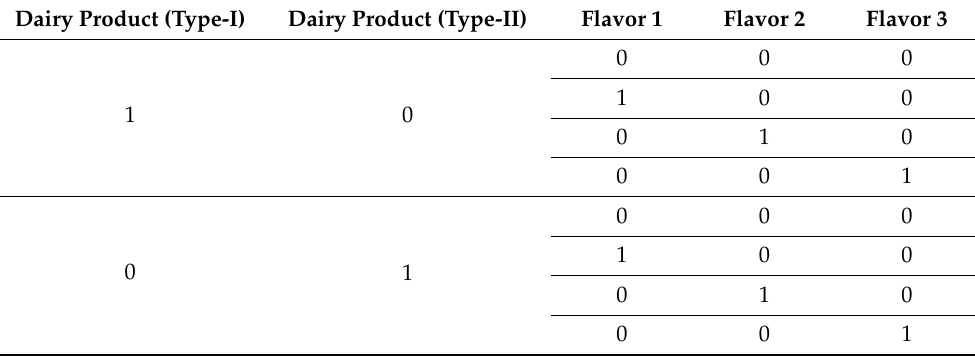
Table 1. Different combinations of dairy product and